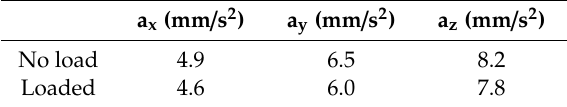
Table 5. Mechanical noise outside the excitation band: RMS of the vibration at f > 50